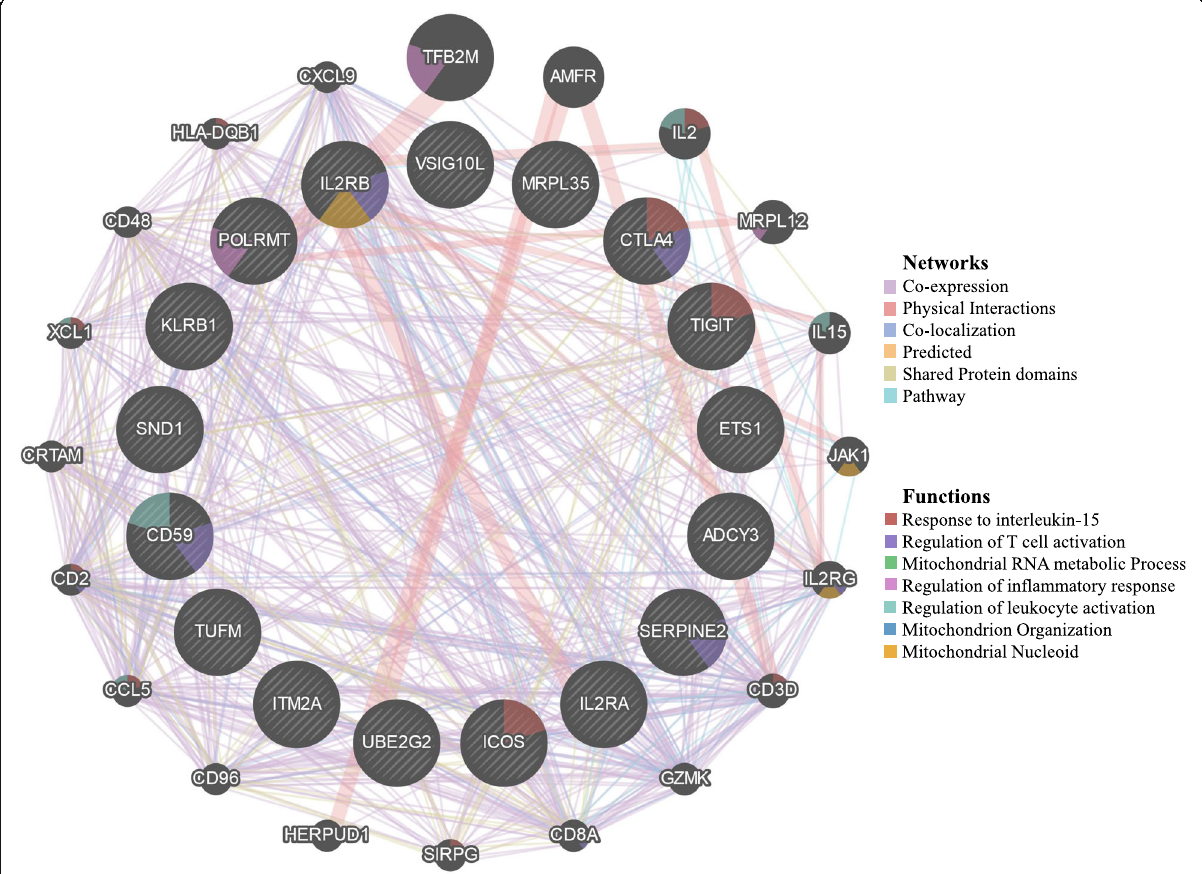
Fig. 2 Construction of a gene-gene network using the top 20 genes with the most significant differential expression. Black circles with white stripes indicate genes that were entered as query terms, while black circles indicate the associated genes. The size of the circle corresponds with the number of correlations with other genes in the